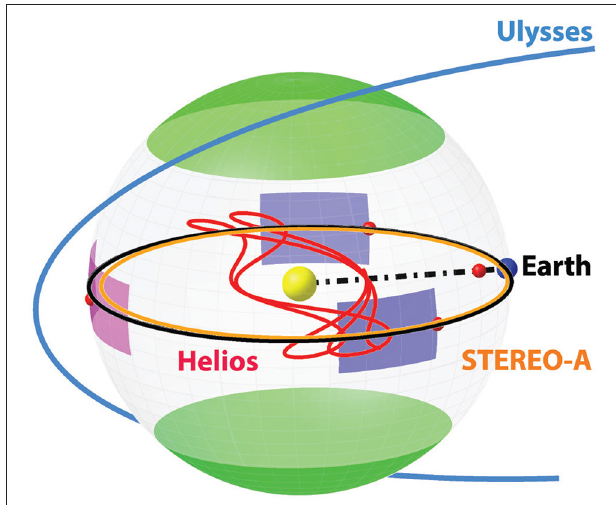
FIGURE 1 | An overview of interesting vantage points, highlighting previous extra-Sun-Earth-line (extra-SEL) missions. Sun and Earth are shown as yellow and blue dots, and Lagrange points are shown as red dots (radial scale deformed for clarity). The SEL is indicated as the black dot-dashed line (intersecting the L1 Lagrange point and Earth). The quadrature views are shown as blue patches (intersecting the L4 and L5 Lagrange points); the far-side view as a pink patch (intersecting the L3 Lagrange point); and the polar views as green patches. Sample STEREO orbit is shown in orange, Helios orbits in red, and Ulysses orbit in light blue. The Helios orbits are relative to the Earth, i.e., Heliocentric Earth Ecliptic (HEE) coordinates, the other orbits are in Heliocentric Inertial coordinates (Thompson,